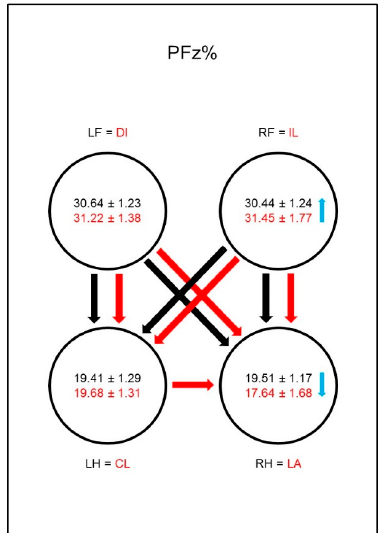
Figure 2. Peak vertical force as a percentage of total force (PFz%) in study group 1 and control group. Black writing and arrows refer to the control group, red writing and arrows refer to the study group. Arrows between the circles indicate significant differences between the individual paws within the respective group. The tip of the arrow always marks the lower value. For example, the lame limb/right hindlimb had a significantly lower PFz% than both front limbs. Blue arrows within the circles mark significant differences in the comparison between control group and study group. The direction of the blue arrows indicates whether an increase (up) or decrease (down) of the values has been observed in the study group. For example, the lame limb of the study group showed a significant decrease in PFz% compared to the right hind limb of the control group. Outlined blank arrows mark differences just outside the significance limit. LF = left front limb, RF = right front limb, LH = left hind limb, RH=right hind limb, LA = lame limb, DI = diagonal limb, IL = ipsilateral limb, CL = contralateral limb. Animals 2020 , 10 , x FOR PEER REVIEW